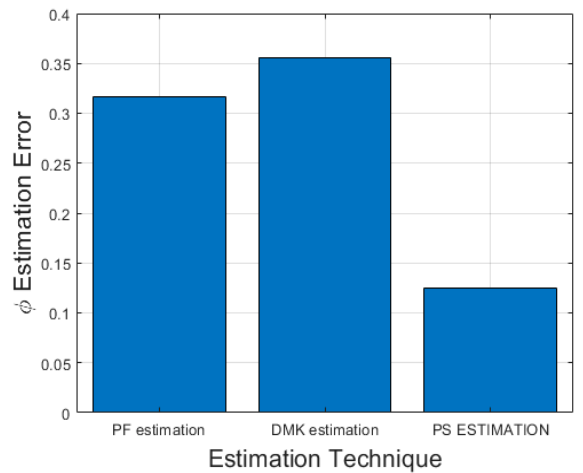
Figure 11. Average RMSE obtained for the measurement of ∅ (cid:3041) .